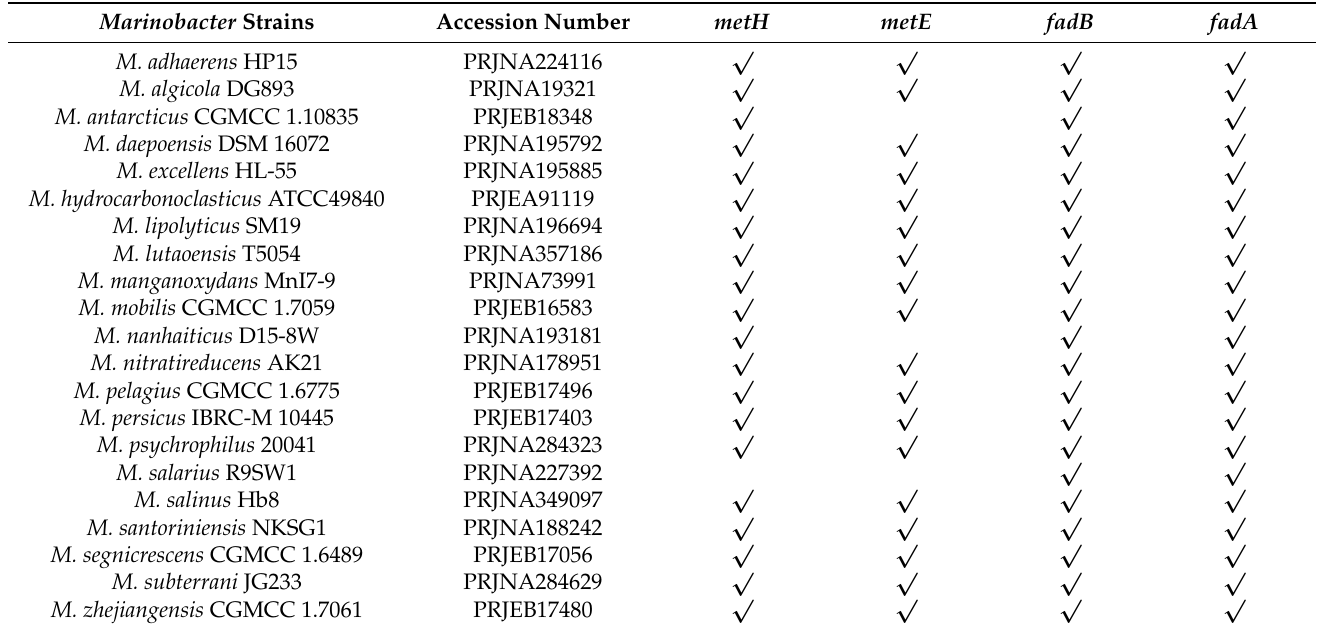
Table 2. Screening of methionine synthase genes and lipid degradation genes in 21 Marinobacter complete genomes (accession numbers in the NCBI). Vitamin B 12 synthase genes are methionine synthase genes ( metH and metE ). Lipid degradation genes are fatty acid degradation alpha subunit genes ( fadB ) and 3-ketoacyl-CoA thiolase genes ( fadA